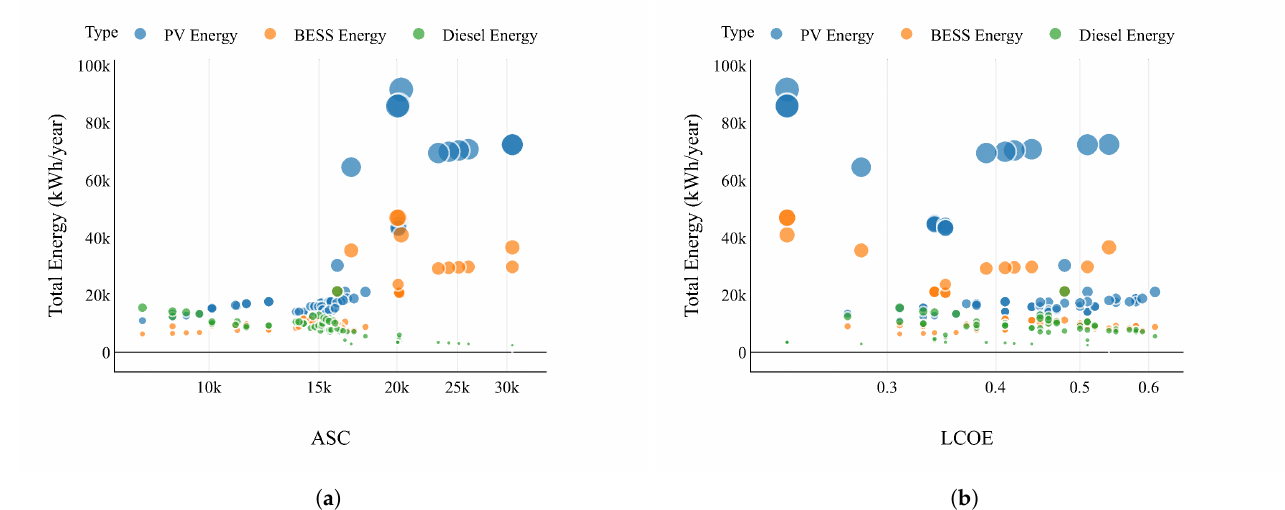
Figure 10. Energy vc ASC and LCOE. ( a ) Energy vs. ASC; ( b ) Energy vs. LCOE.